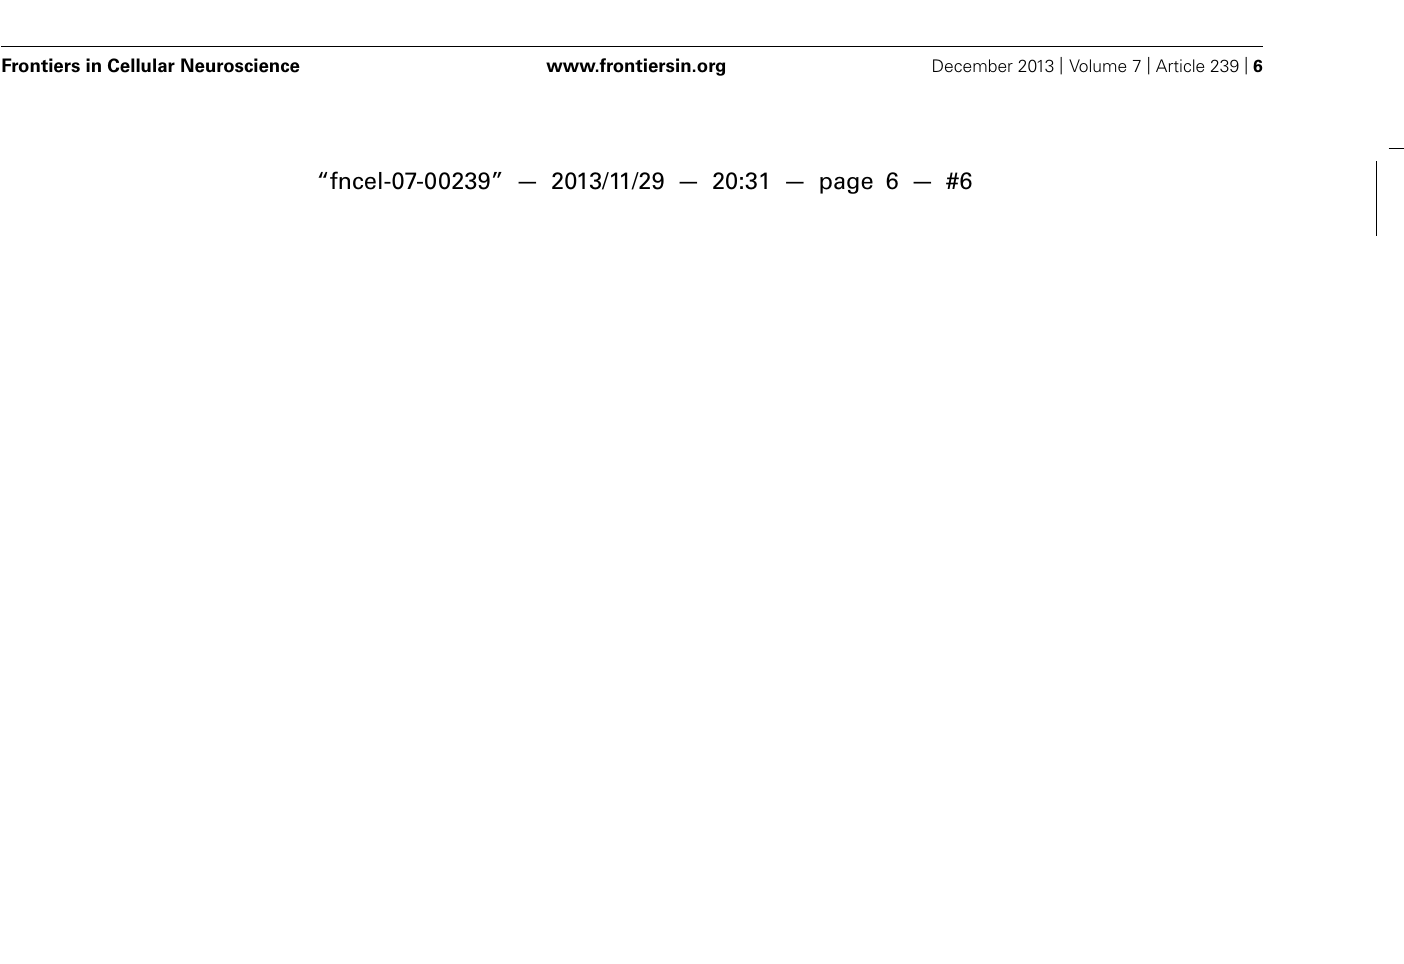
subcellular localization of Golgi fragments. Immunocytochemistry against MAP1B was used to stain the cell cytoplasm and nuclei counter staining Topro-3. Bar, 20 μ